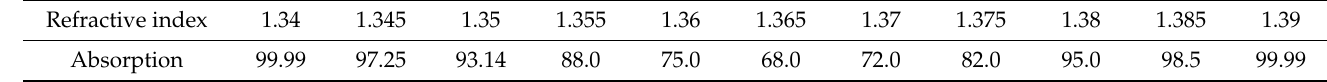
Table 3. Variation in peak absorption with respect to the refractive index.